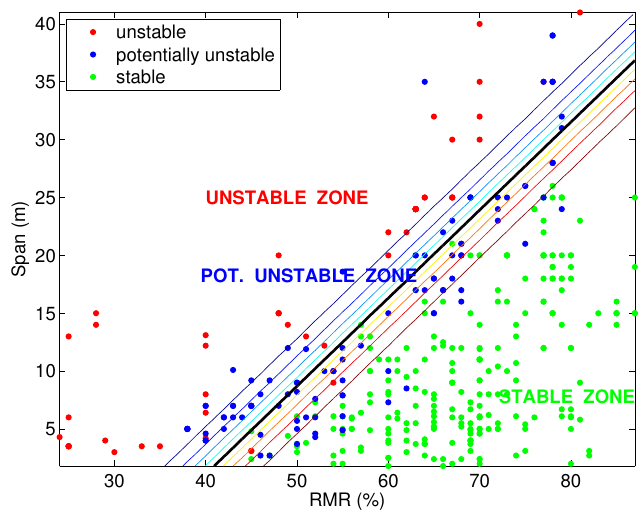
Figure 4. Critical span graph: SVM binary probabilistic classification with the linear kernel.